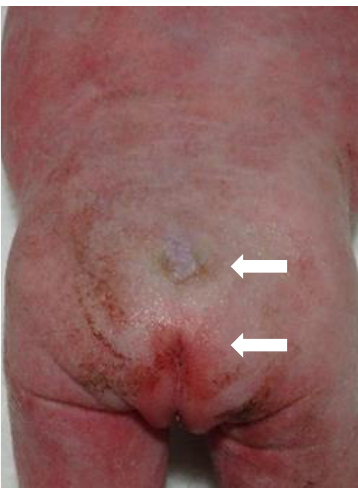
Figure 6. 3D ultrasound image of the lumbosacral region.